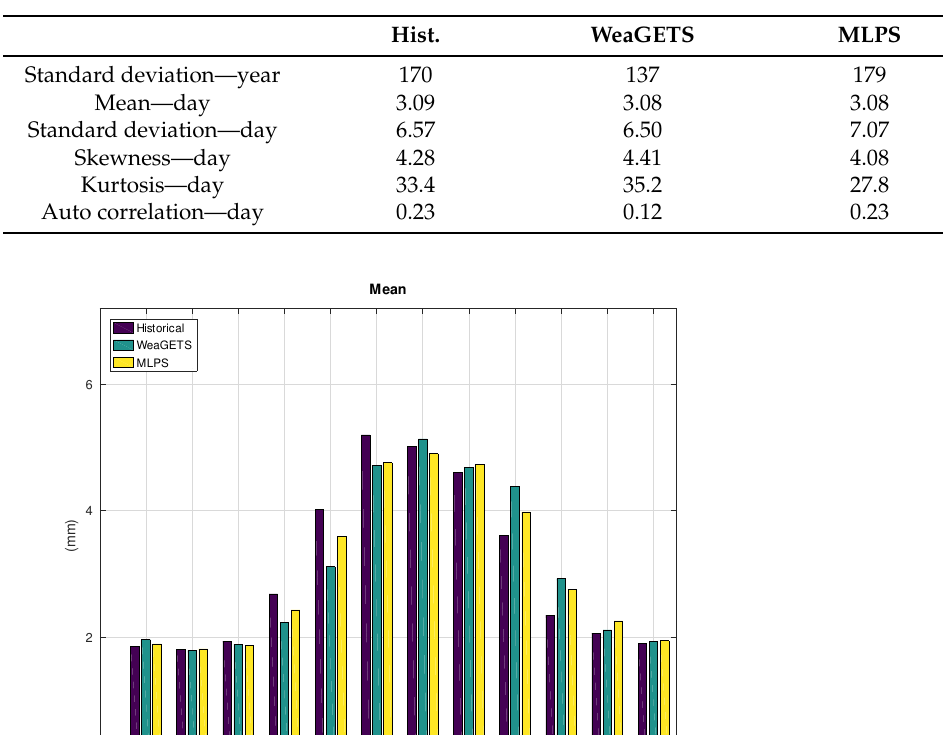
Table 1. Statistics of the synthetic time series of WeaGETS and MLPS and of the historical time series of rainfall on Hohenpeissenberg.